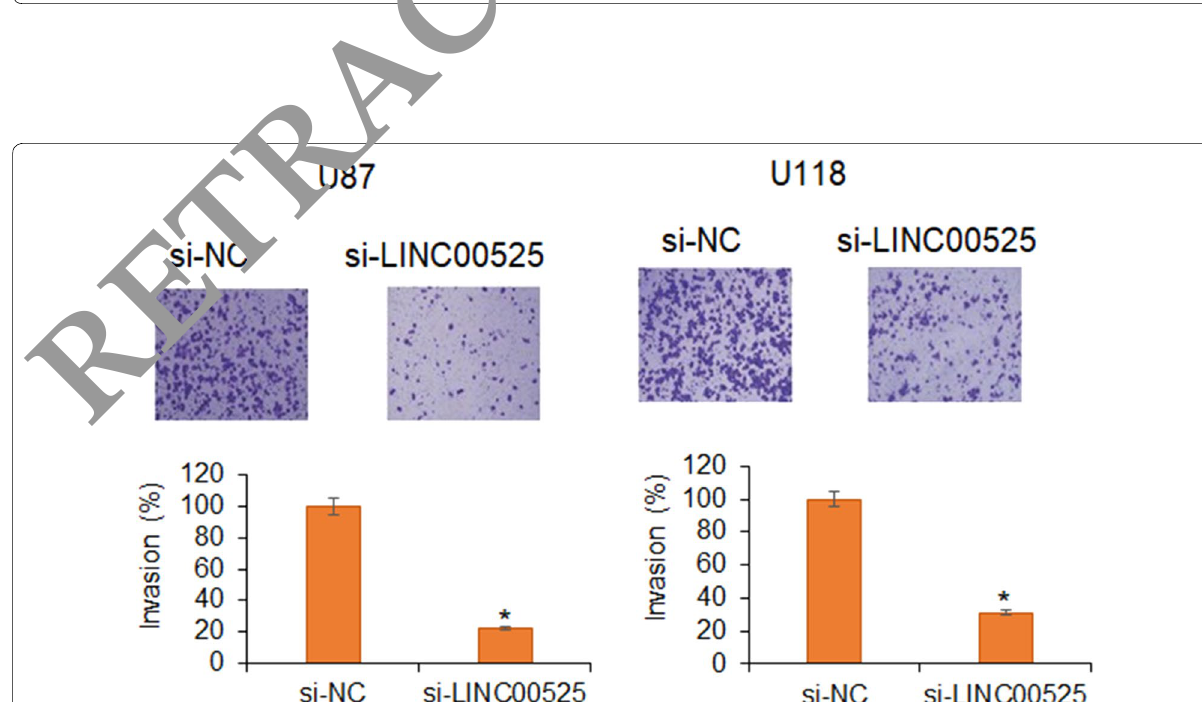
Fig. 4 lncRNA-LINC00525 knockdown restricts the glioma cell invasion. Analysis of invasion U87 and U118 cancer cells transfected with si-NC or si-LINC00525 by transwell assay. The experiments were performed in triplicate and expressed as mean